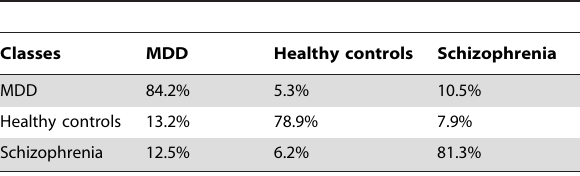
Table 2. Confusion matrix for results in leave-one-out cross-